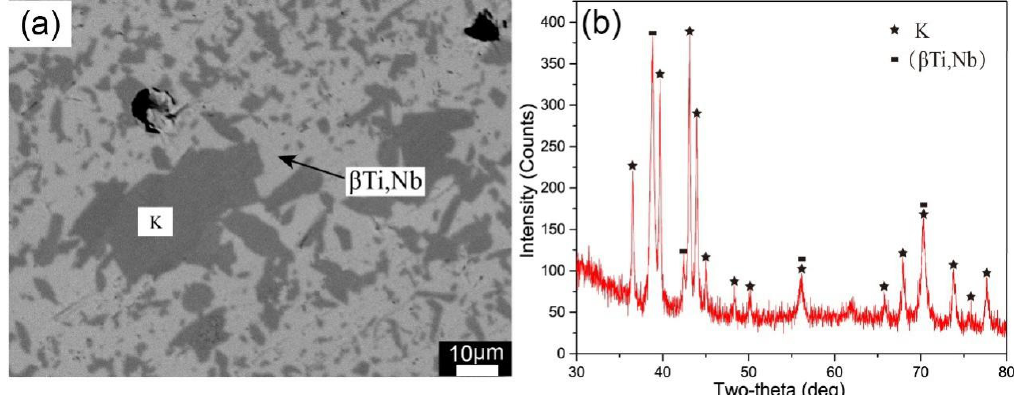
Figure 8. Alloy A7 annealed at1173K for 90 days: ( a ) back-scattered electron (BSE) images and ( b ) XRD patterns.